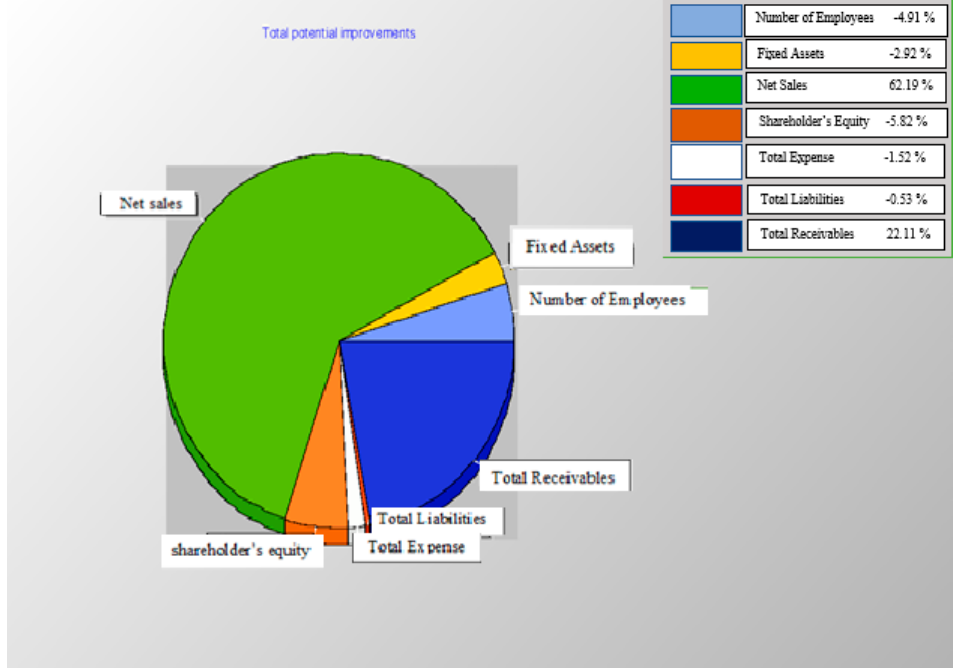
Figure 9. Maximum focused method potential improvement rates with the CCR Model.